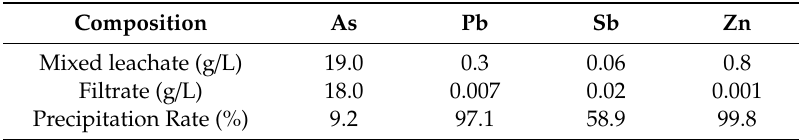
Table 5. Results of purification